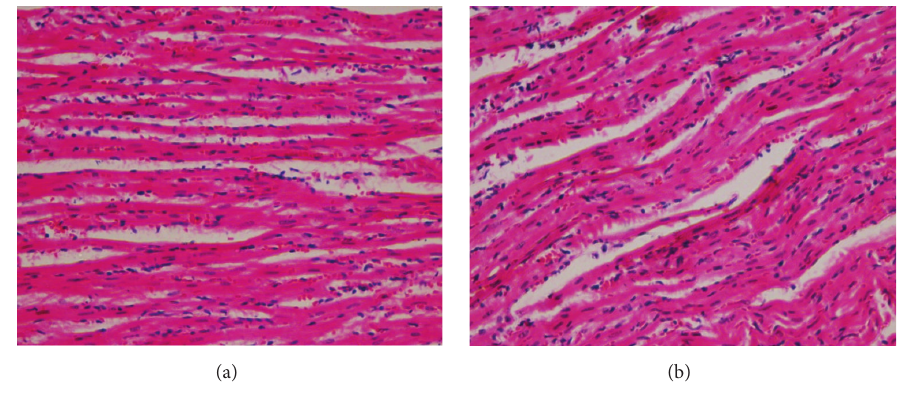
Figure 4: (a) Treated heart. (b) Control heart.